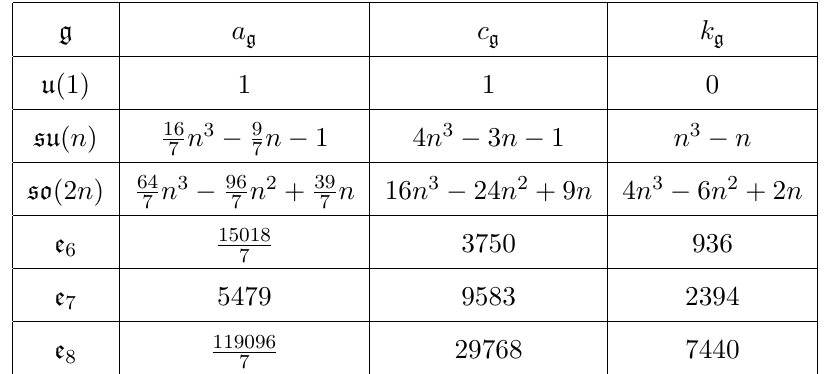
Table 1 . Weyl and so (5) R anomalies for all (2 ; 0) SCFTs T g